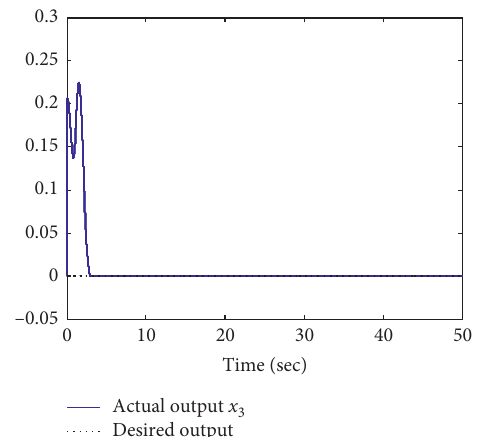
Figure 2: Trajectories of the second output x